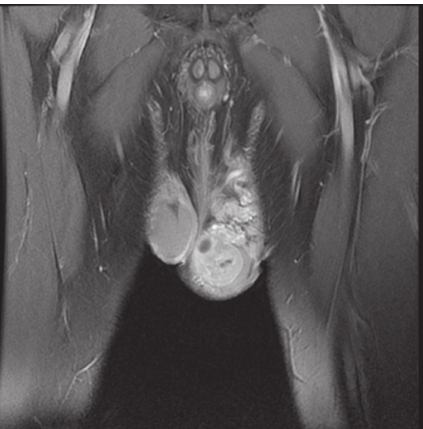
Figure 1: Coronal T1-weighted MRI image demonstrating a tumor that occupies the largest part of the left testis.